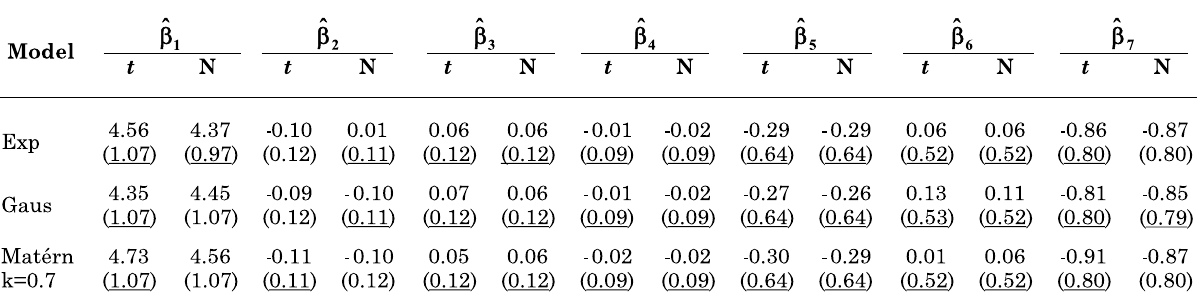
Table 1. Parameters estimated by LM assuming Student’s t -distribution with v = 3 and normal for soybean yield using theoretical models: exponential (Exp), Gaussian (Gaus), and Matérn with k = 0.7 (Matérn)